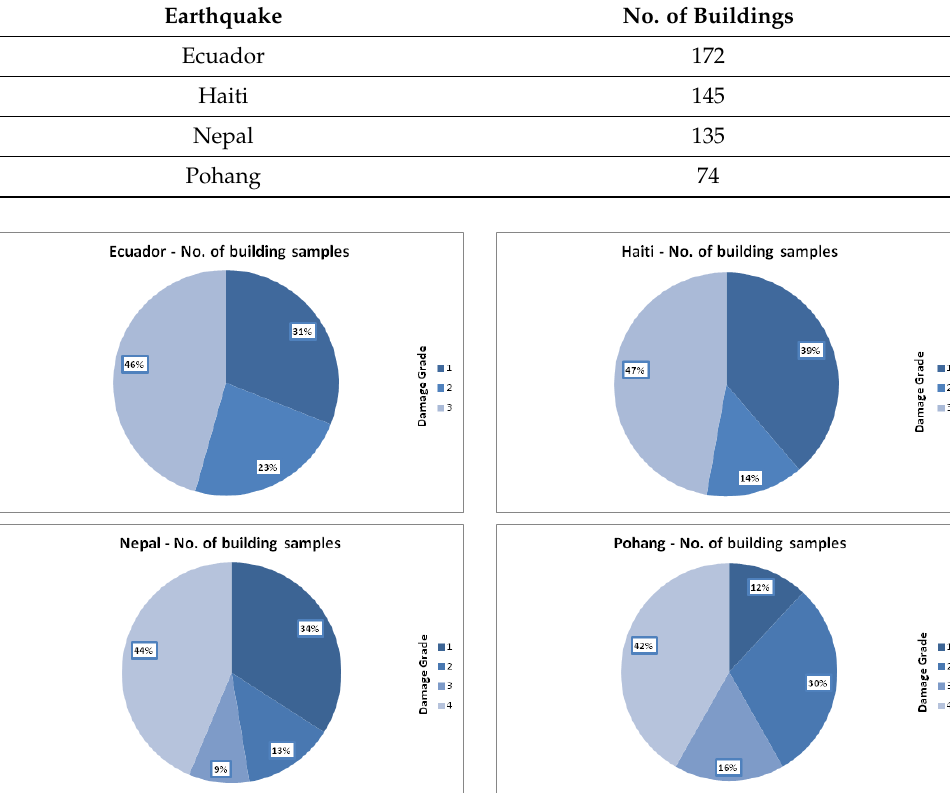
Figure 3. Distribution of input data based on the damage scale: Data from Ecuador and Haiti have a distribution over three categories, whereas the data for Nepal and Pohang are classified with four different